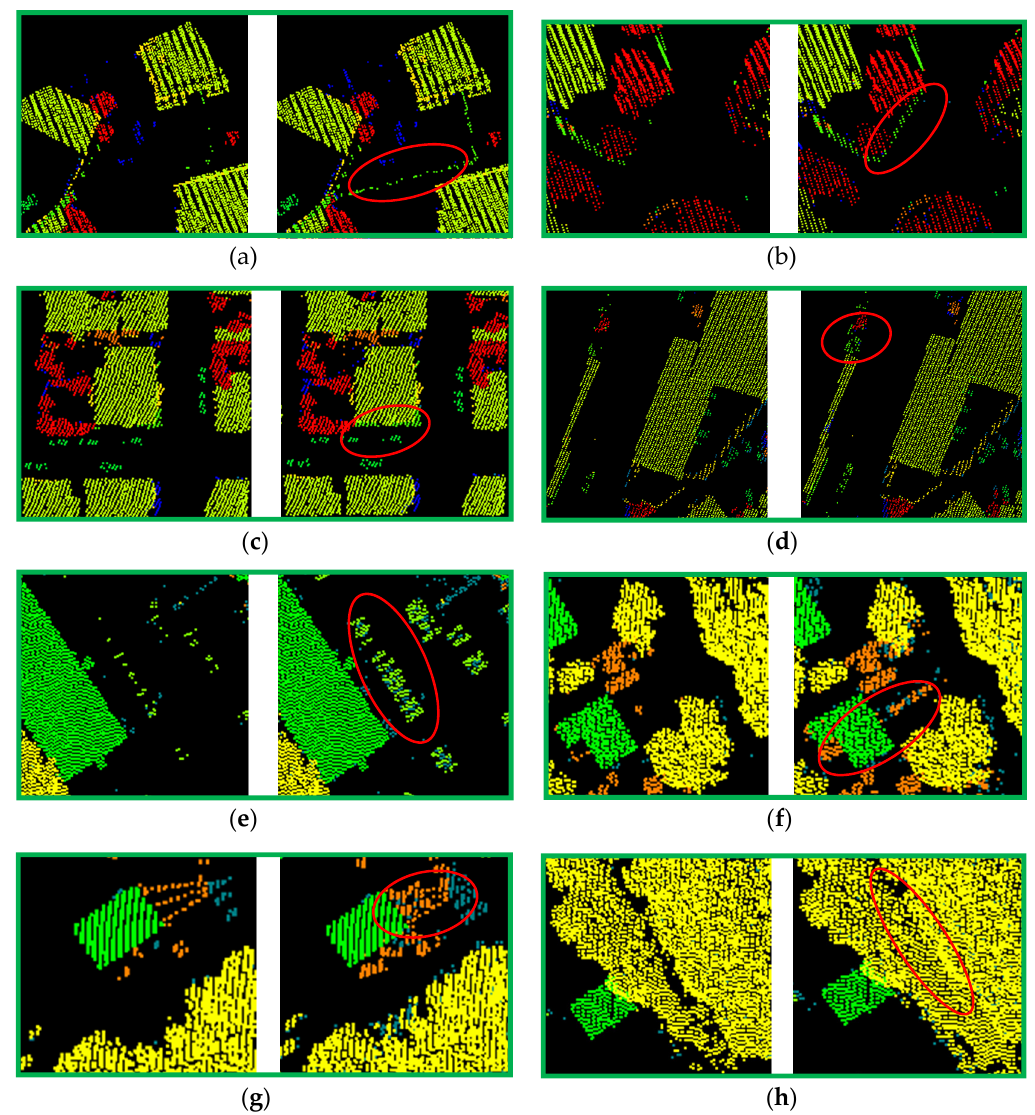
Figure 9. Comparison of CSF method with our off-ground points filtering method: ( a )–( d ) More façade points, car points, etc., can be integrated into off-ground points for Vaihingen Dataset; ( e )–( h ) more car points, vegetation points, etc., can be integrated into off-ground points for GML Dataset A. To better evaluate the e ff ectiveness of the LCS-CRF model, the qualitative results for three classification algorithms (i.e., RF, CRF, and LCS-CRF) of the two test datasets are, respectively, shown in Figures 11 and 12. To learn the RF models, 400 trees are su ffi cient in our work. One thousand training samples for each class are randomly chosen from the reference ground-truth data of Vaihingen Dataset and GML Dataset A. The performance of RF in the case of limited training samples can be shown in Figure 11a,b and Figure 12a,b. The soft labeling results for each class, produced by RF, are considered as the unary term of CRF and